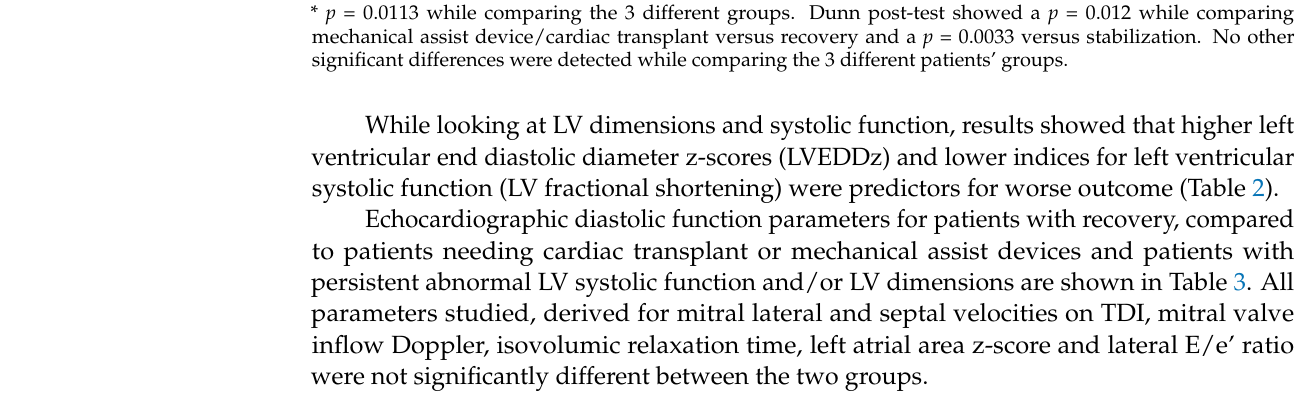
Table 2. Echocardiographic data for LV dimensions and systolic function. Data are presented as median and interquartile range (IQR).